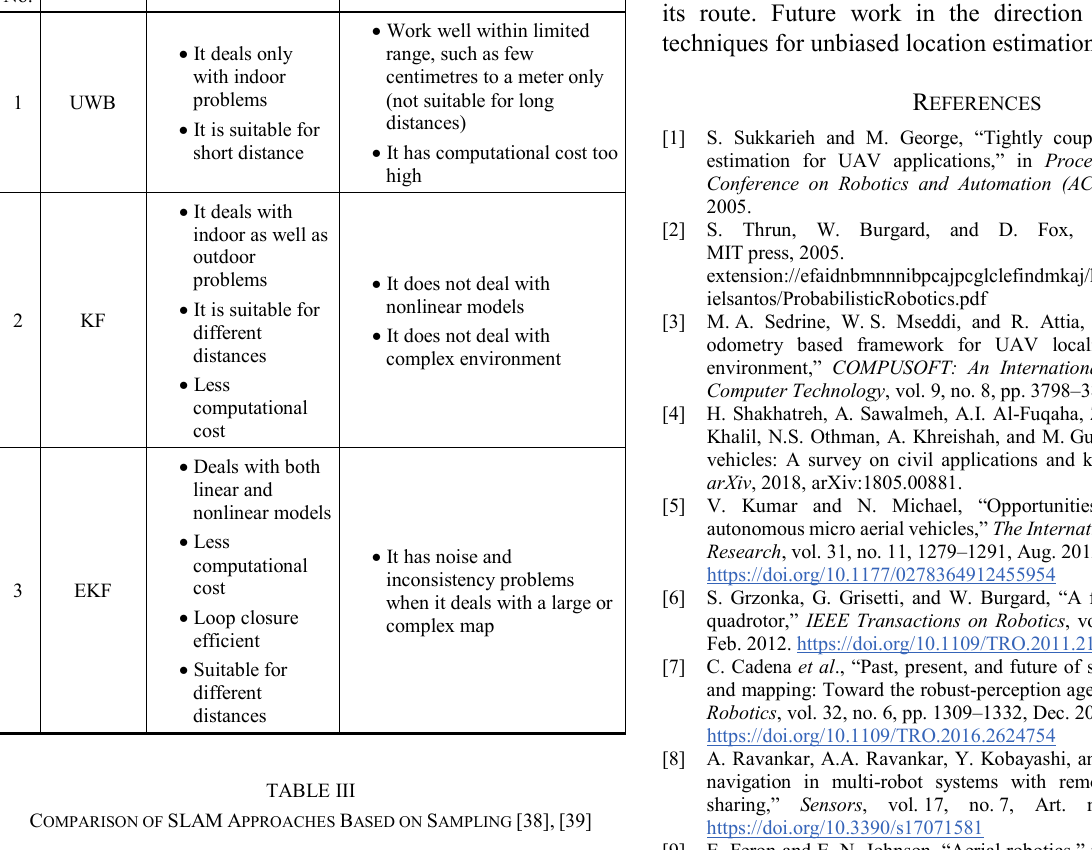
C OMPARISON OF SLAM T ECHNIQUES B ASED ON A DVANTAGES AND D ISADVANTAGES [37] Sr. No.